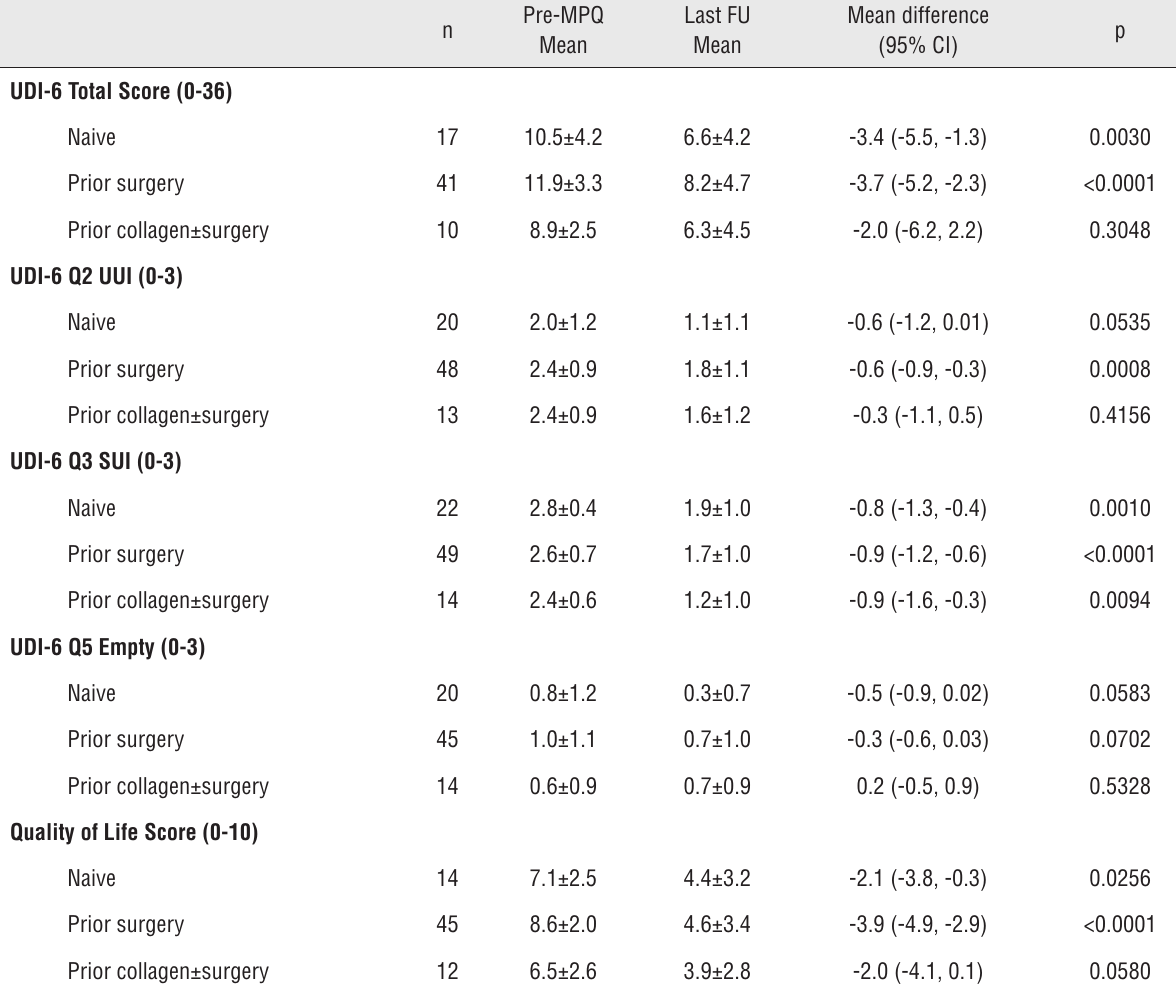
Table 3 - Changes in UDI-6 and QoL questionnaire responses by prior incontinence treatment